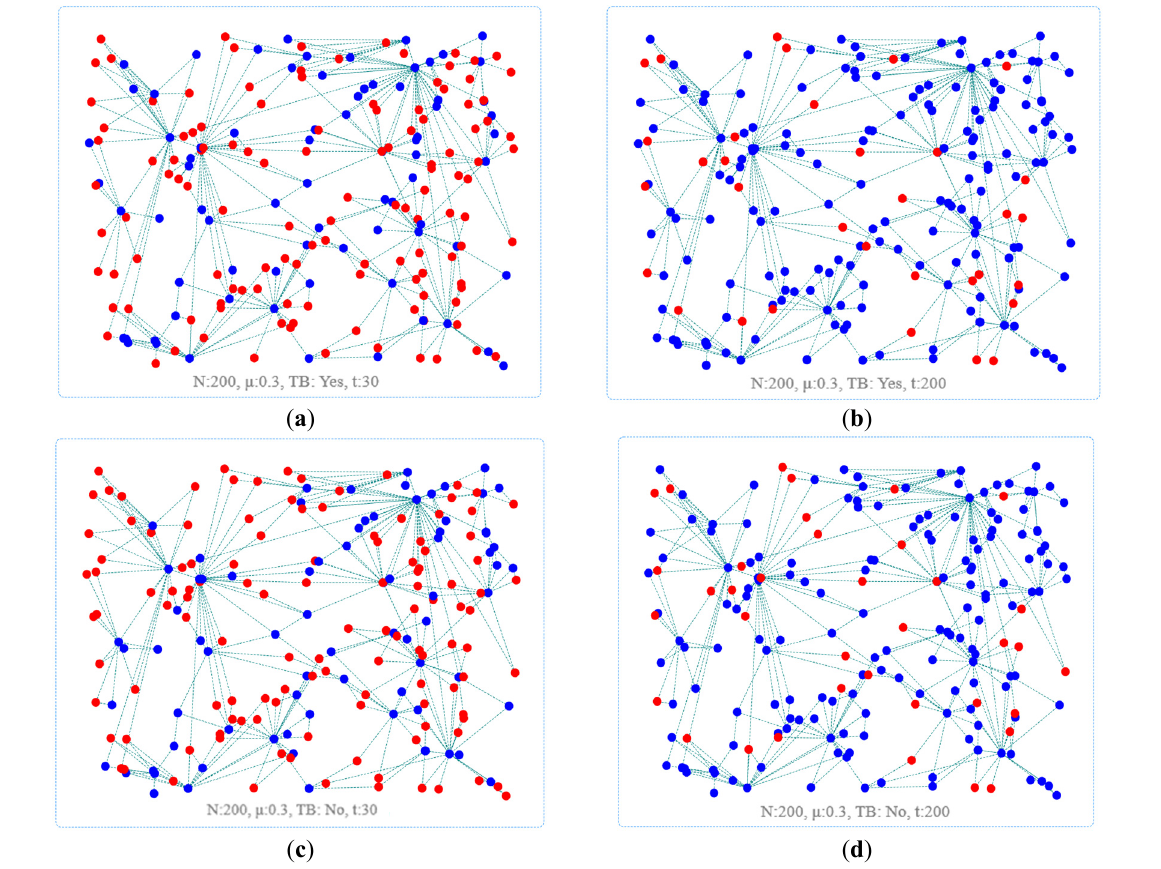
Figure 4. Influence of CID on BCW under trust boundary (Number of firms = 200). Note: the red node means normal bidders, the blue node means collusive bidders, and the node’s size represents the degree of the node.